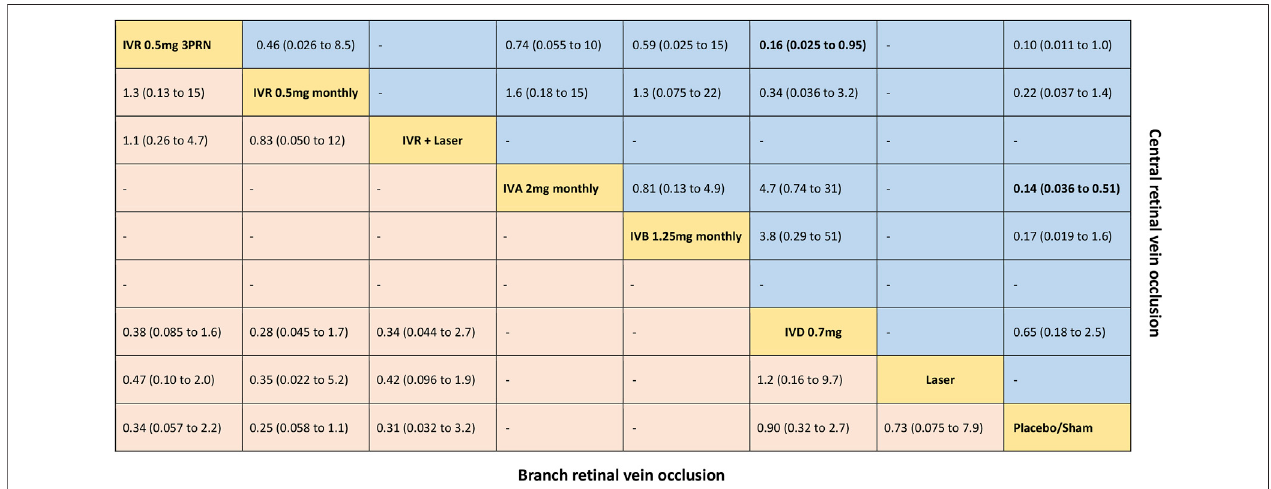
FIGURE 3 | Comparative effectiveness of pharmacotherapies in terms of the proportion of patients who gained ≥ 15 letters in BCVA for macular edema secondary toretinal veinocclusioninnetworkmeta-analysis.Relativerisk(95%credibleinterval)forcomparisonsareincellsincommonbetweencolumn-de fi ningandrow-de fi ning treatment. Bold cells are signi fi cant. For branch retinal vein occlusion, relative risk < 1 favors row-de fi ning treatment. For central retinal vein occlusion, relative risk < 1 favors column-de fi ning treatment.